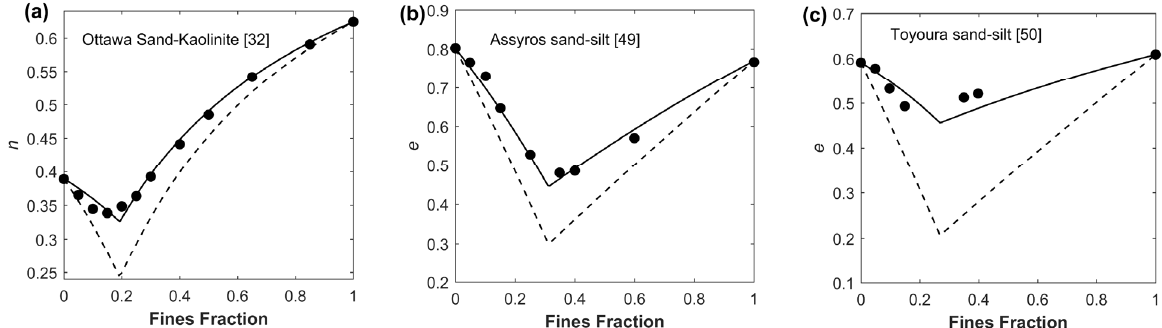
Figure 5. Porosity ( n ) or void ratio ( e ) as function of fines fraction for different binary mixed soils containing cohesive packing. Subfigures ( a )–( c ) show different examples from different binary mixed soils where the source of the data is cited in the upper part of the plot. Dashed curves refer to the model prediction without accounting for fines cohesive packing (Equations (1), (2) and (6)) while solid curves correspond to the prediction of the modified model (Equations (1), (2), and (7)–(9)).